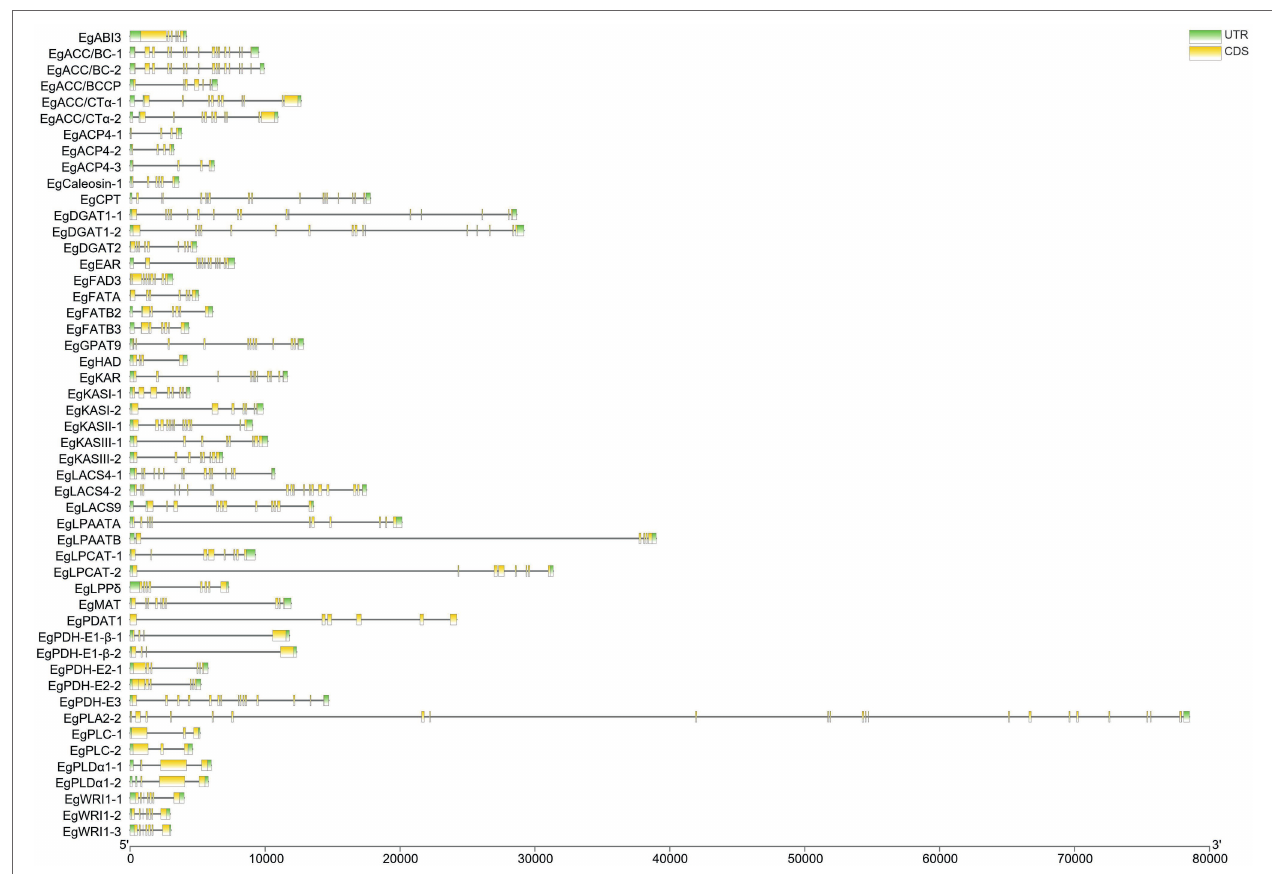
FIGURE 2 | The gene structure of enzyme genes related to the biosynthesis of fatty acid in Elaeis